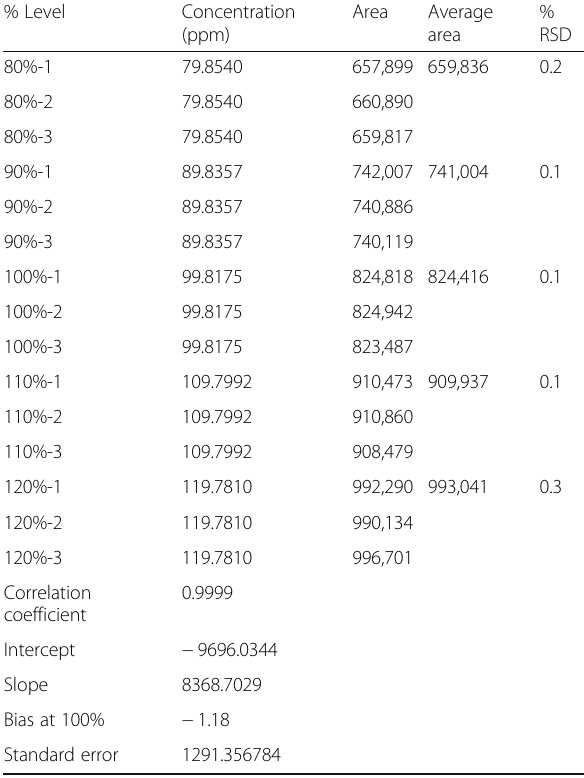
Table 5 Linearity of detector response of